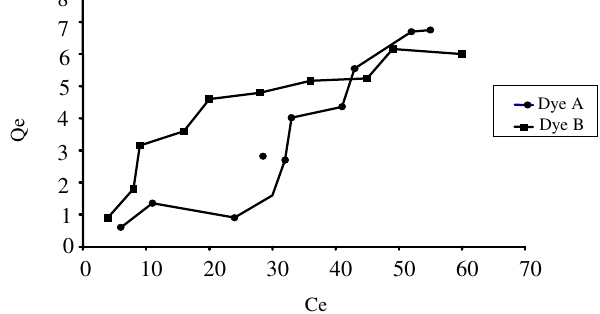
Figure 3. Adsorption isotherms of dye A and B at pH 12 and 2 respectively